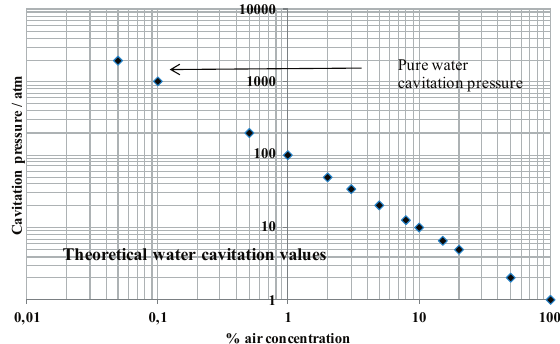
Figure 4. Calculated cavitation pressures for water obtained using Equation (8).